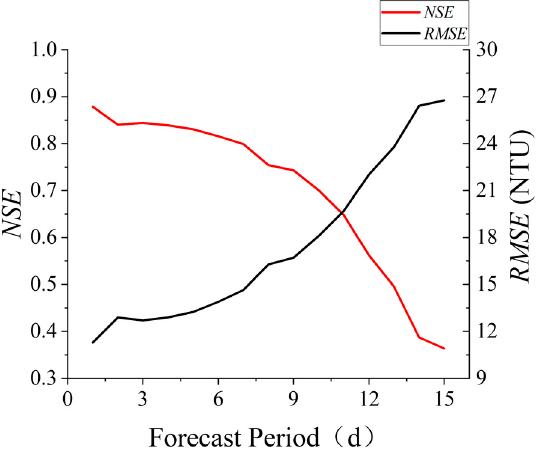
Figure 7. NSE and RMSE of the LSTM model with future wind speed as an additional input variable.